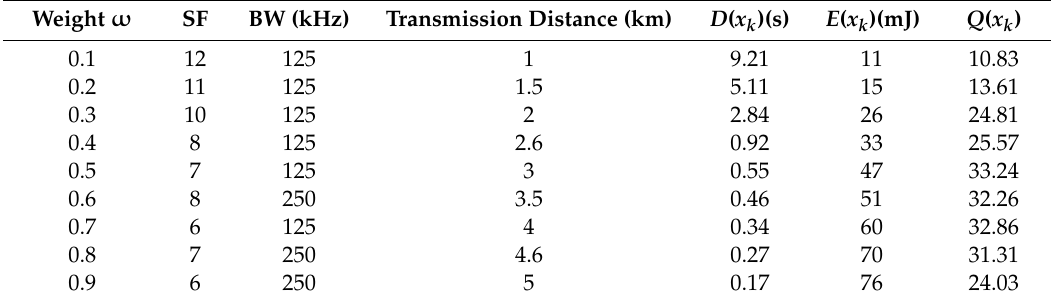
Table 3. Sensor parameters of the network parameter monitoring node under di ff erent weights ω .